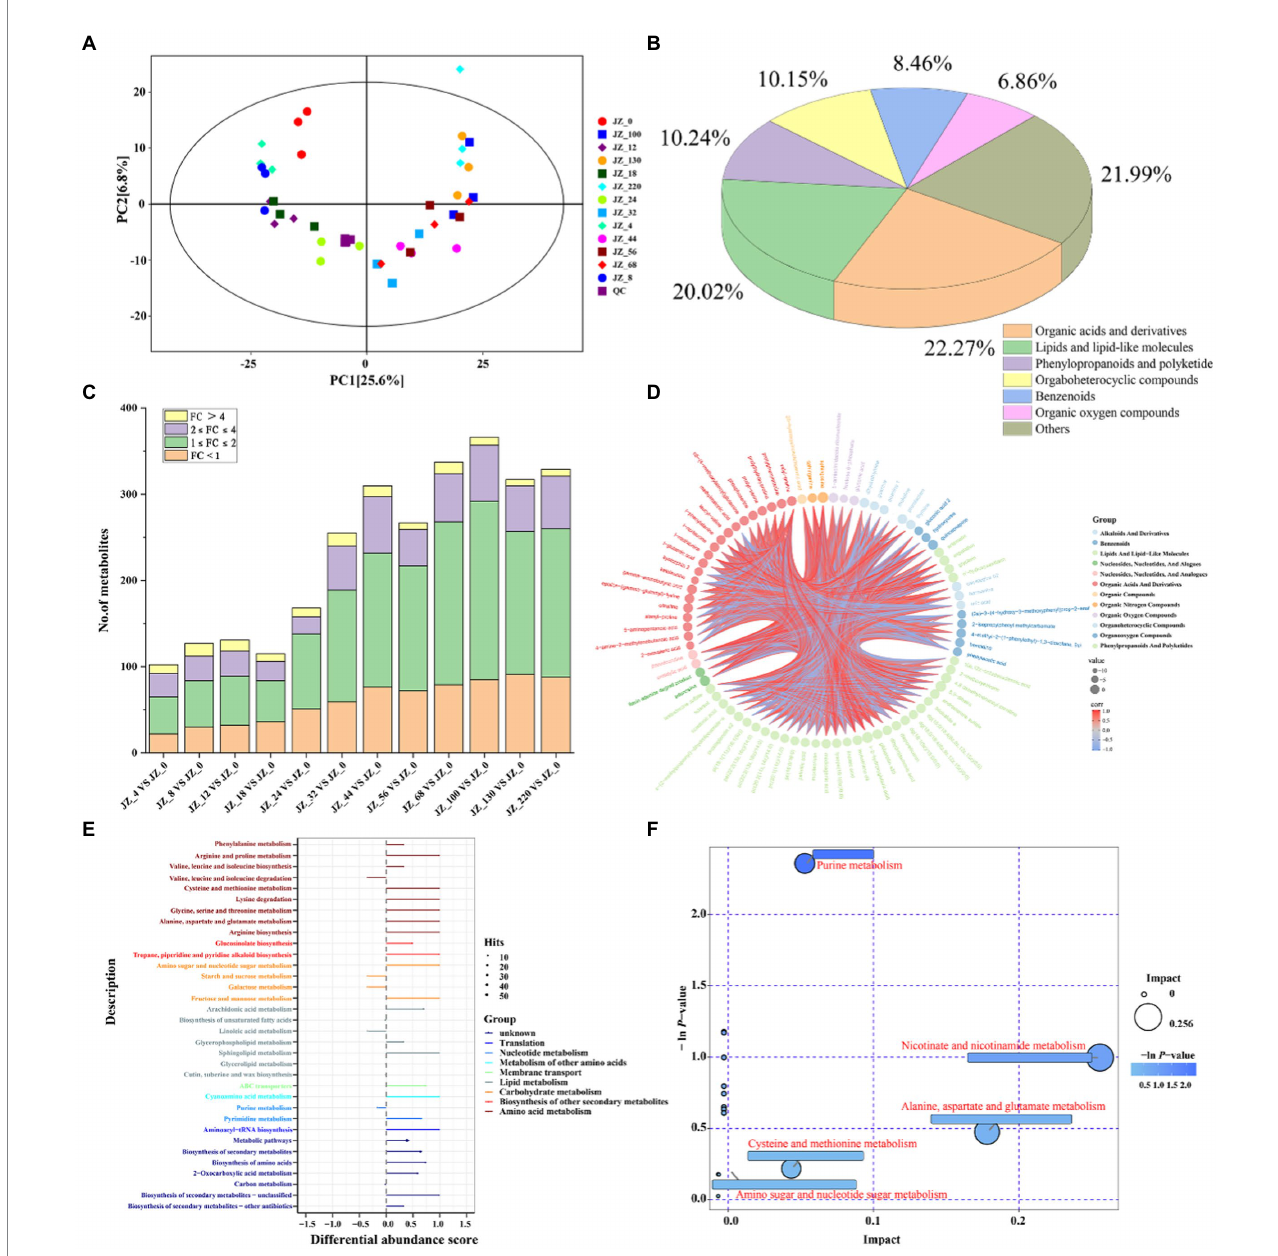
FIGURE 6 Metabolome analysis in Jiupei during fermentation process. (A) PCA score plot in Jiupei during fermentation process. (B) Classification of fermented Jiupei metabolites. (C) Differential metabolite species compared at different fermentation time points and the 0th day of fermentation. (D) Differential metabolite analysis of Z_18 VS JZ_0. (E) KEGG pathway analysis for differential metabolites. (F) Pathway bubble diagram of differential